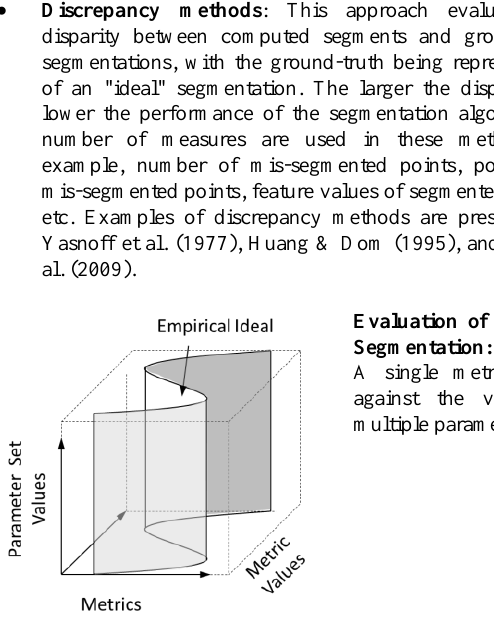
Figure 2 Discrepancy methods. Metrics, their values and parameter sets for a single segmentation are defined in an N- dimensional space. The metrics for a segmented reference point cloud (the empirical ideal) is mapped into this space. The parameter sets that yield segmentations that map into